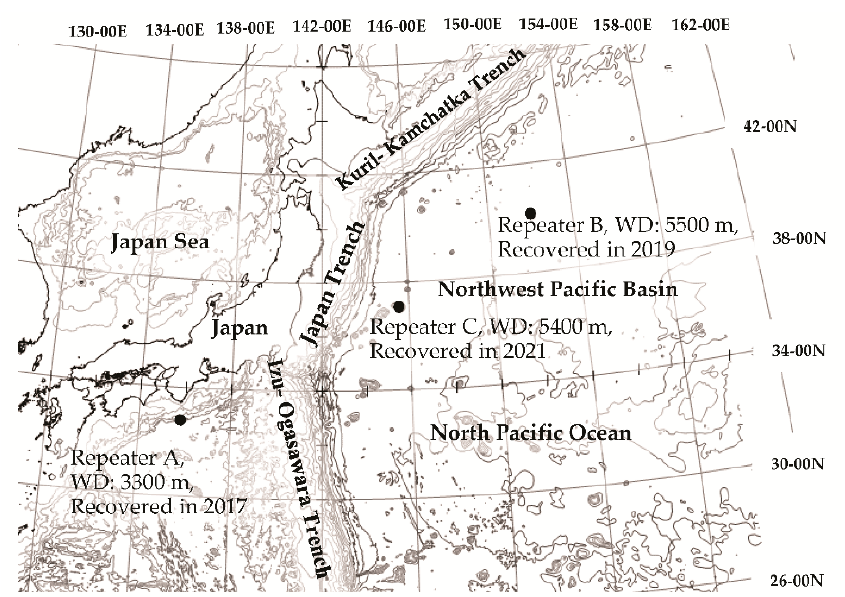
Figure 20. Positions of the recovered repeaters; WD: water depth. The isobaths are shown based on GEBCO (General Bathymetric Chart of the Oceans), Edition 2003, and blue isobaths show 1000 m interval.